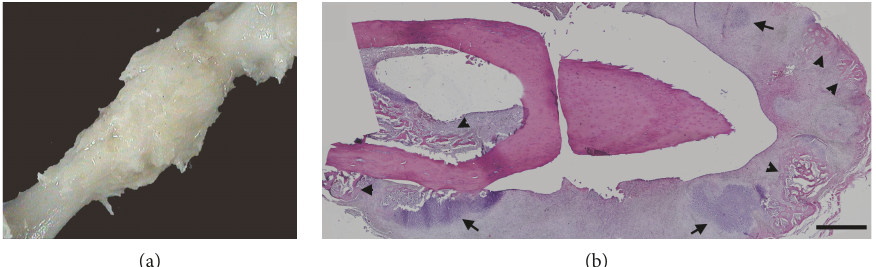
Figure 4: The gross (a) and microscopic (b) appearances of osteotomy site in the osteogenic-sheet group at the end of the second week. Callus formation was observed in the osteogenic-sheet group at the osteotomy site at the end of the second week (a). In microscopic examination, the osteogenic-sheet group exhibited a mainly cartilaginous (arrows) but also at some locations bony elements (arrow heads) containing callus formation at the end of the second week (b). Scale bar =1 mm for (b).